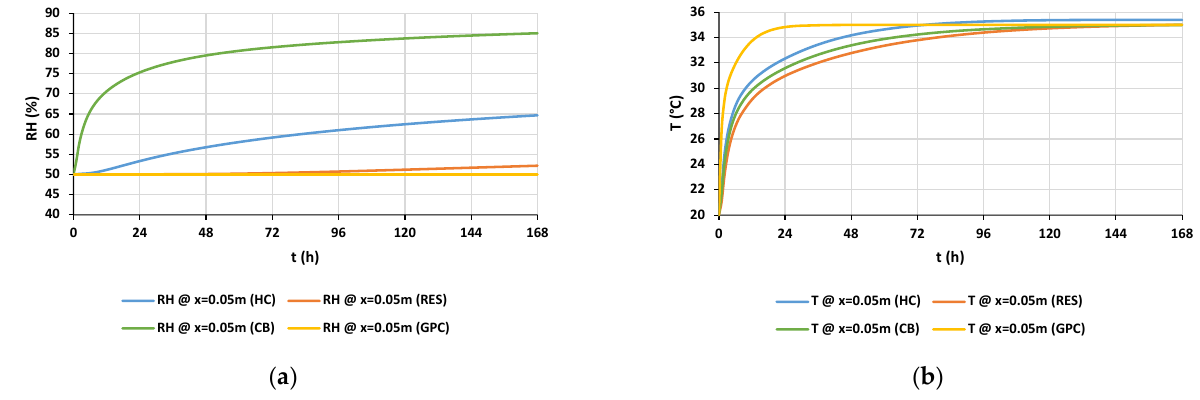
Figure 21. Temporal evolution of RH ( a ) and temperature ( b ) at 0.05 m for HC, cob, and GPC. After 168 h, the RH does not reach equilibrium for any of the three materials. The simulations have been therefore extended to one year in order to have more representative effects (Figure 22). After 3 months, the equilibrium is reached for CB. For HC, the equilib- rium is almost reached after 1 year. However, for RES and GPC, the equilibrium is far from being reached, with relative higher value for RES in comparison to GPC.